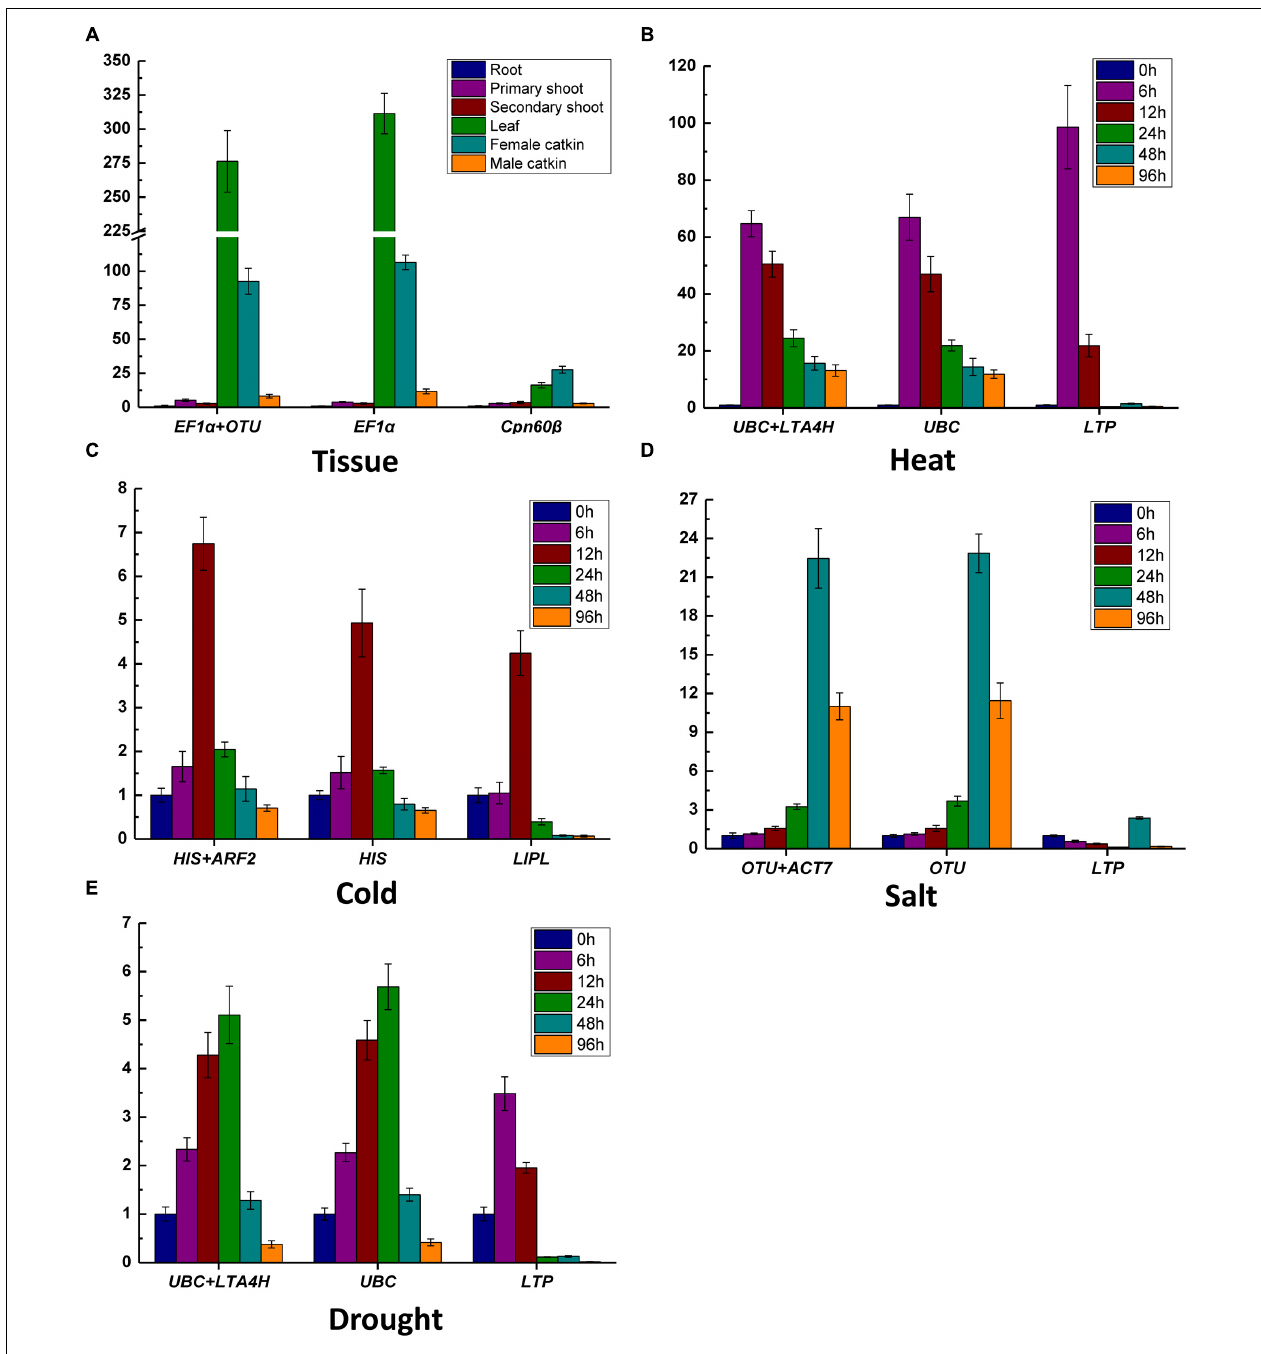
FIGURE 5 | Validation of the identified reference genes. The relative expression levels of WOX1a (A) , Hsf-A2 (B) , CBF3 (C) , HKT1 (D) , and GST (E) were normalized by the most stably RGs and the least stable RGs in the different samples. The transcript abundance of WOX1a in root was used as control in (A) , and the transcript abundances of four genes ( Hsf-A2 , CBF3 , HKT1, and GST ) at 0 h were set to be the control in (B–E) , individually. Values shown are relative expression levels ± SE ( n = 3